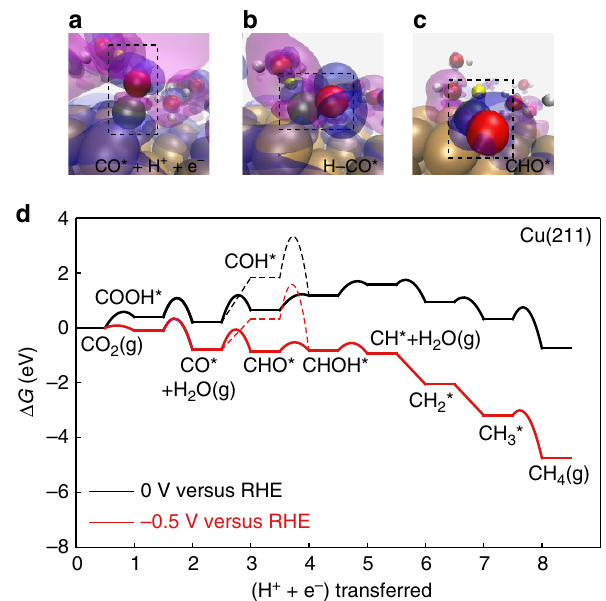
Figure 1 | Free energy diagram. ( a – c ) charge density difference isosurfaces for the rate determining, proton-electron transfer to *CO to form *CHO. *CO, the *H–CO complex and *CHO have been highlighted with dashed lines. Blue and magenta isosurfaces correspond to charge densities of (cid:2) 0.001eBohr –3 and þ 0.001eBohr –3 , respectively. The isosurfaces illustrate the transfer of positive charge to the negatively charged slab along the reaction pathway. ( d ) free energy diagram for the reduction of CO 2 to CH4 on Cu(211) at 0 V and (cid:2) 0.5 V versus